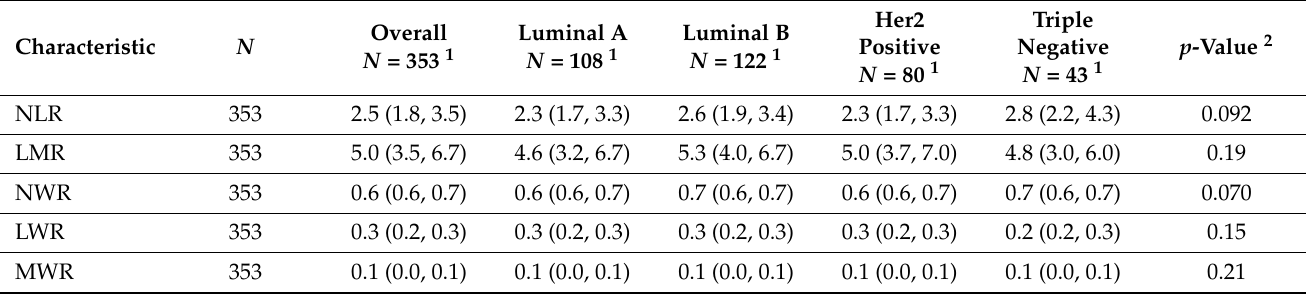
Table 3. Median systemic immunocyte ratios.